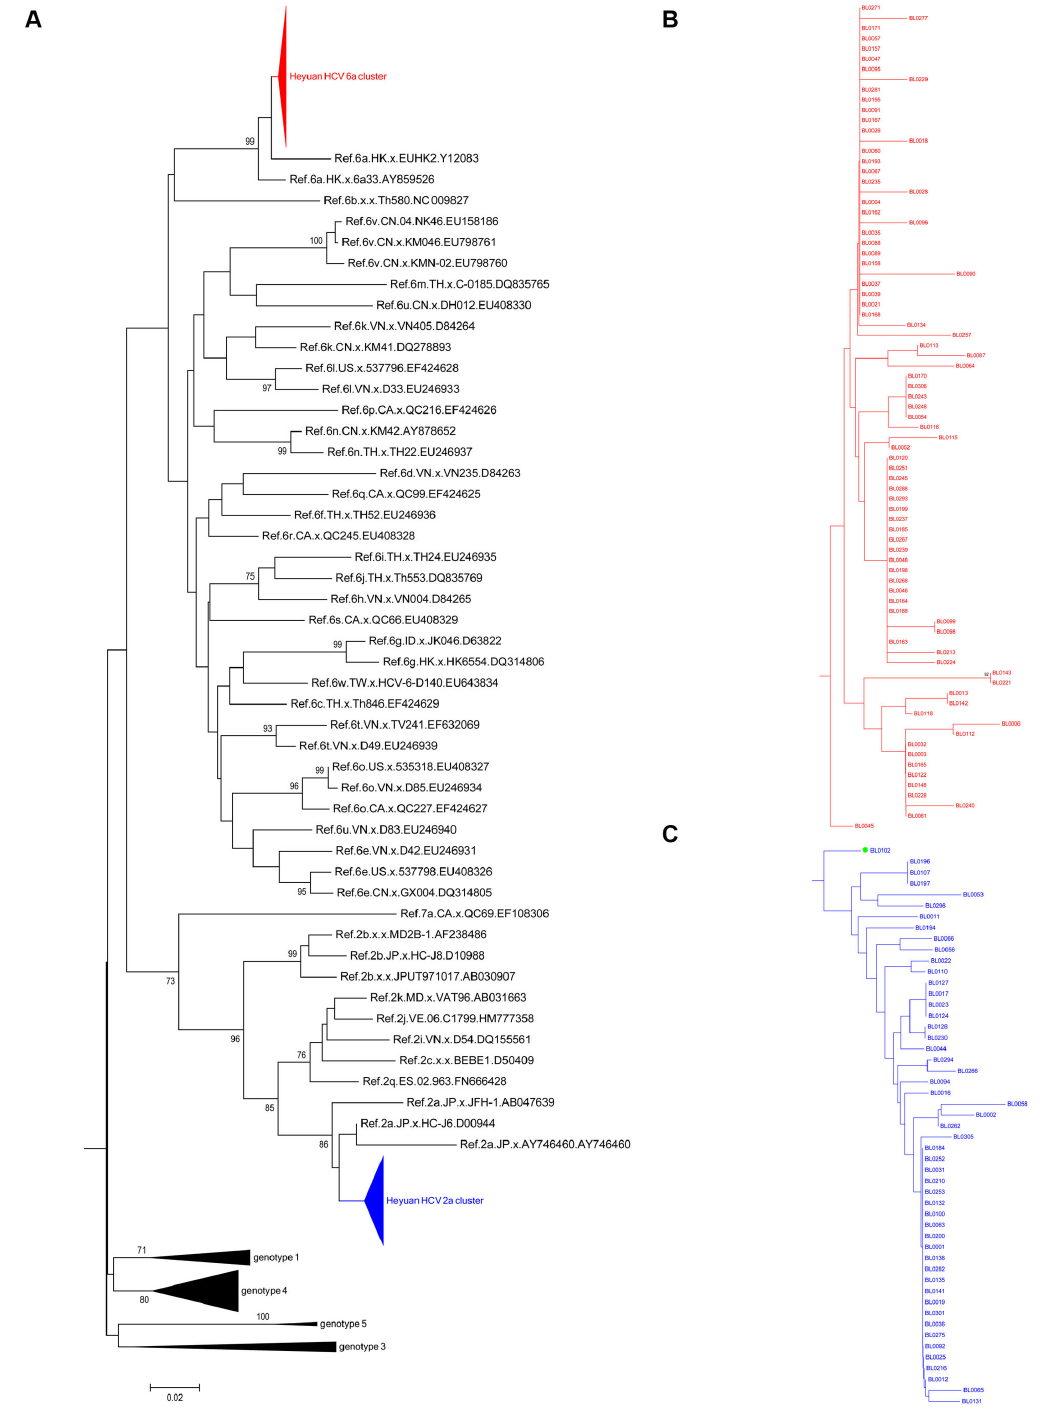
Figure 1. HCV molecular phylogenetic tree based on the Core sequences. The Neighbor-joining phylogenetic tree was constructed based on the Core gene containing 374 nucleotides, corresponding to 332-705 of H77 genome (NC_004102) (A). The red filled triangle indicates the 6a cluster of Heyuan HCV-infected cases; the blue filled triangle indicates the 2a cluster. Genotypes 1, 3, 4, and 5 were collapsed into black filled triangle. The subtrees of Heyuan HCV 6a cluster (B) and 2a cluster (C) display the detailed phylogenetic relations of all Heyuan HCV cases. Bootstrap values are based on 1 000 replicates and statistic values > 70% are indicated at the nodes of the corresponding branches. The scale bar unit is substitutions/site. doi: 10.1371/journal.pone.0082304.g001 PLOS ONE |